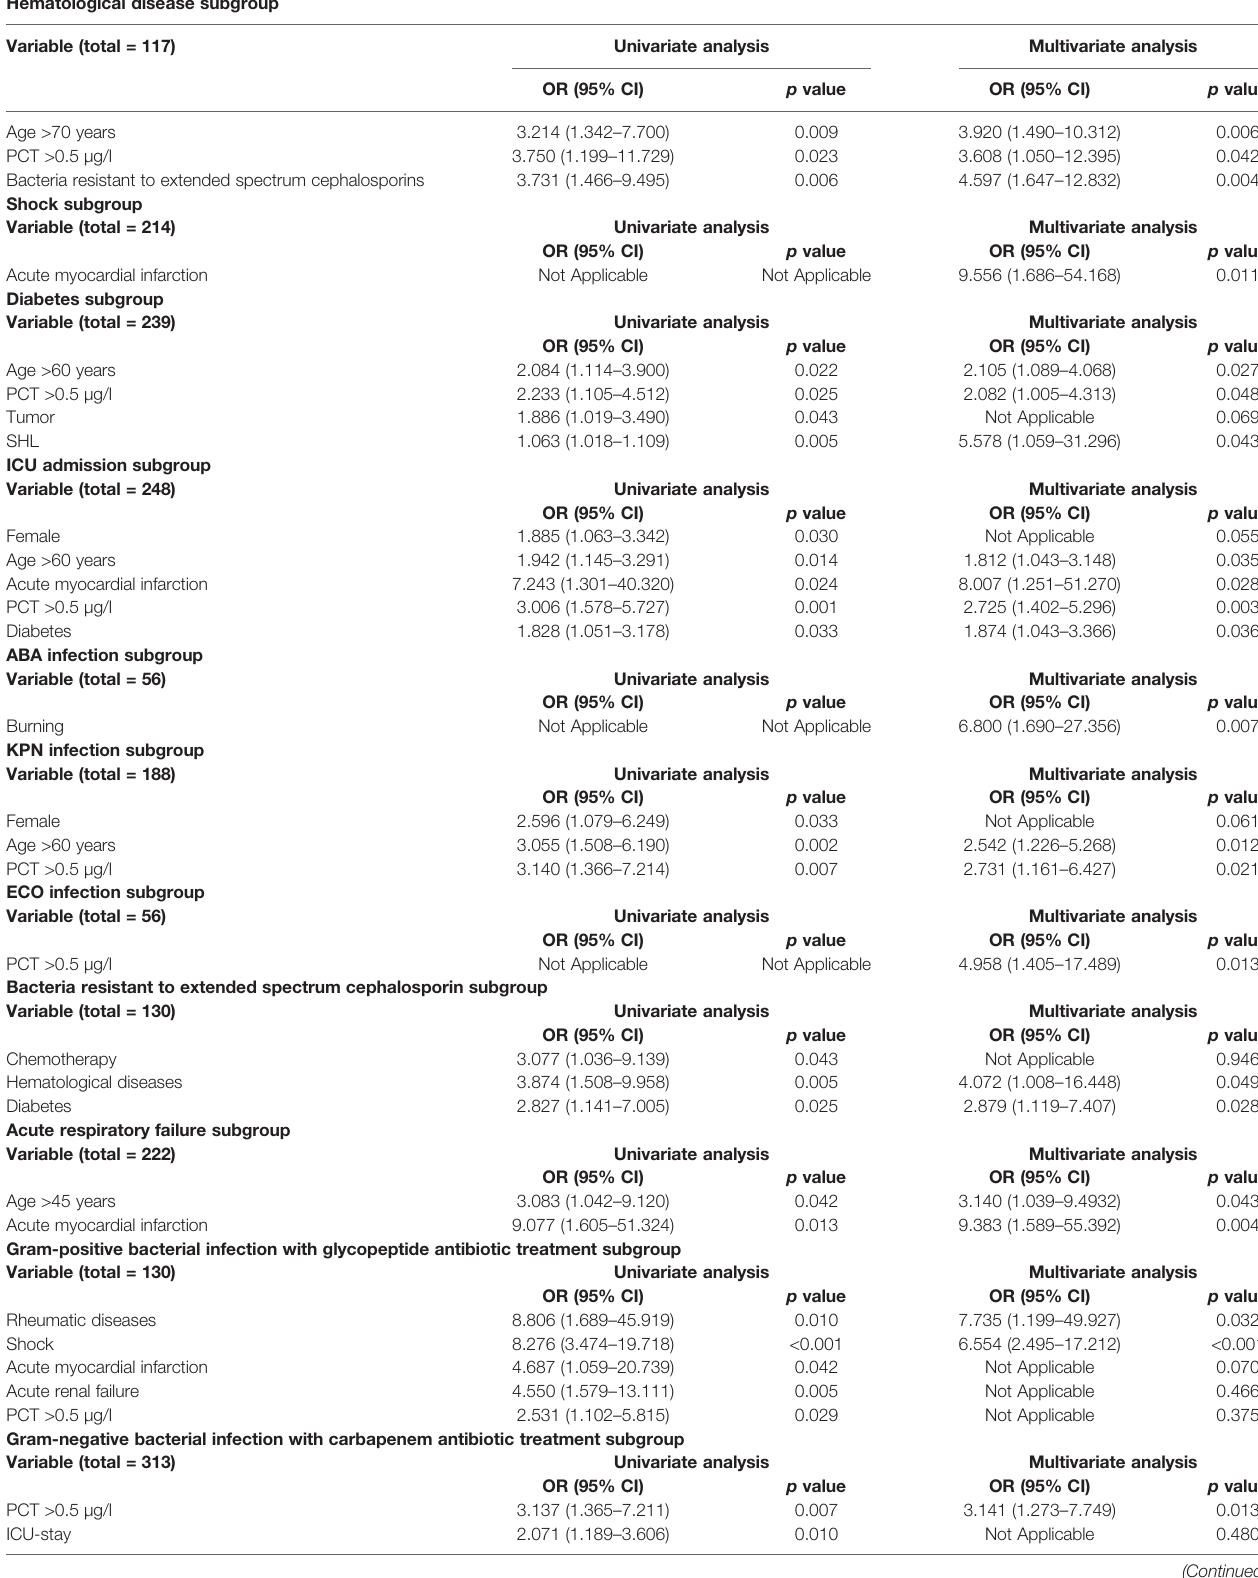
TABLE 2 | Risk factors associated with 60-day mortality in different subgroups by univariate and multivariate analyses. Hematological disease